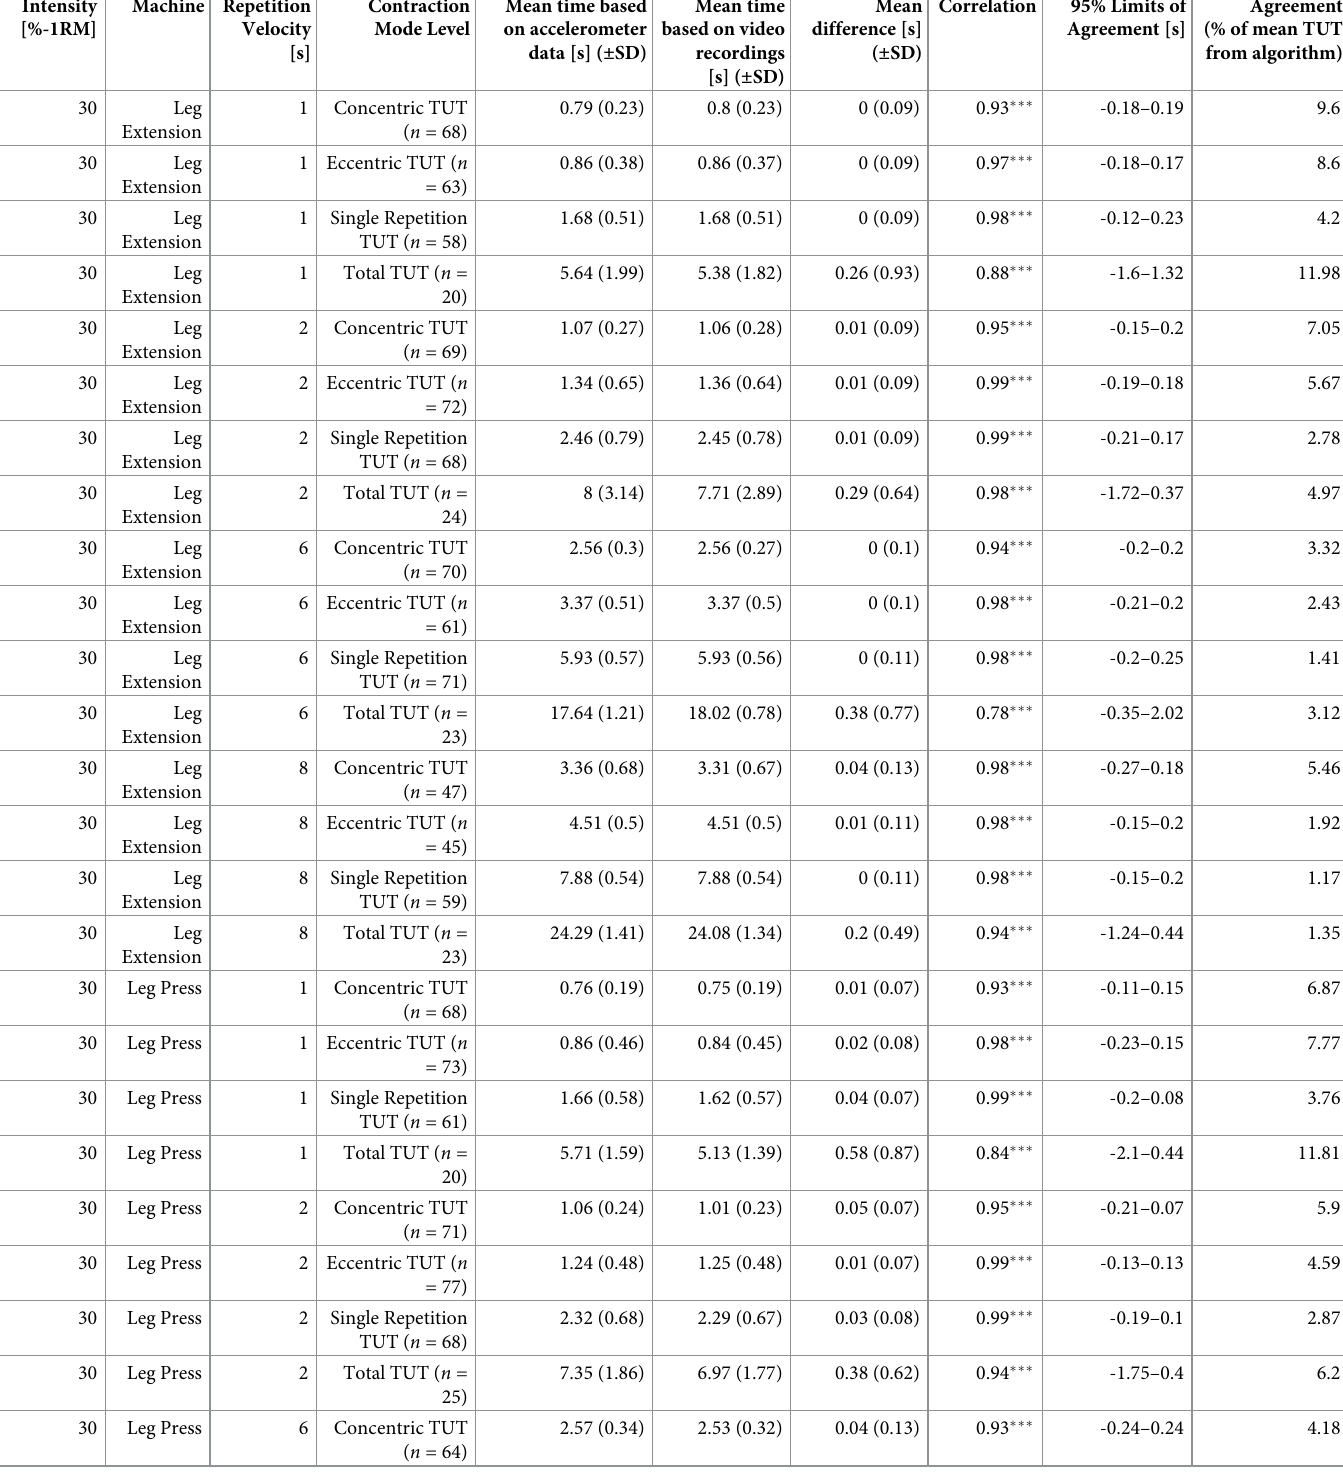
Table 2. Agreement between concentric, eccentric, single repetition and total time-under-tension, derived from algorithmic accelerometer data and video